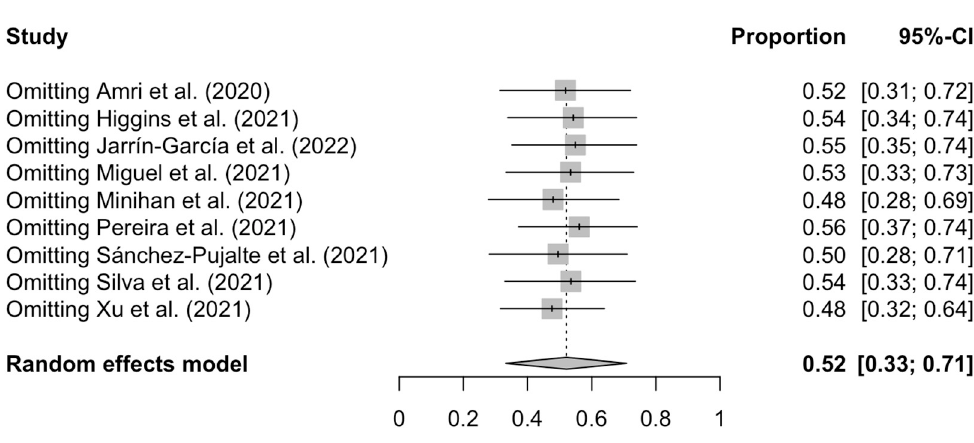
Figure 3. Sensitivity forest plot for the prevalence of burnout [40–48].